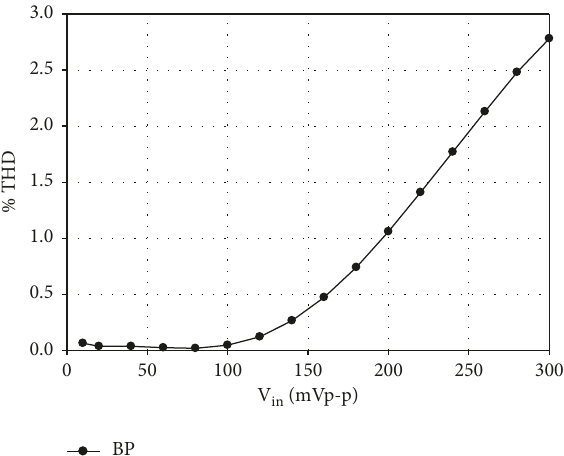
Figure 15: Simulated THD of the band-pass filter versus the input amplitude at f � 200 kHz.